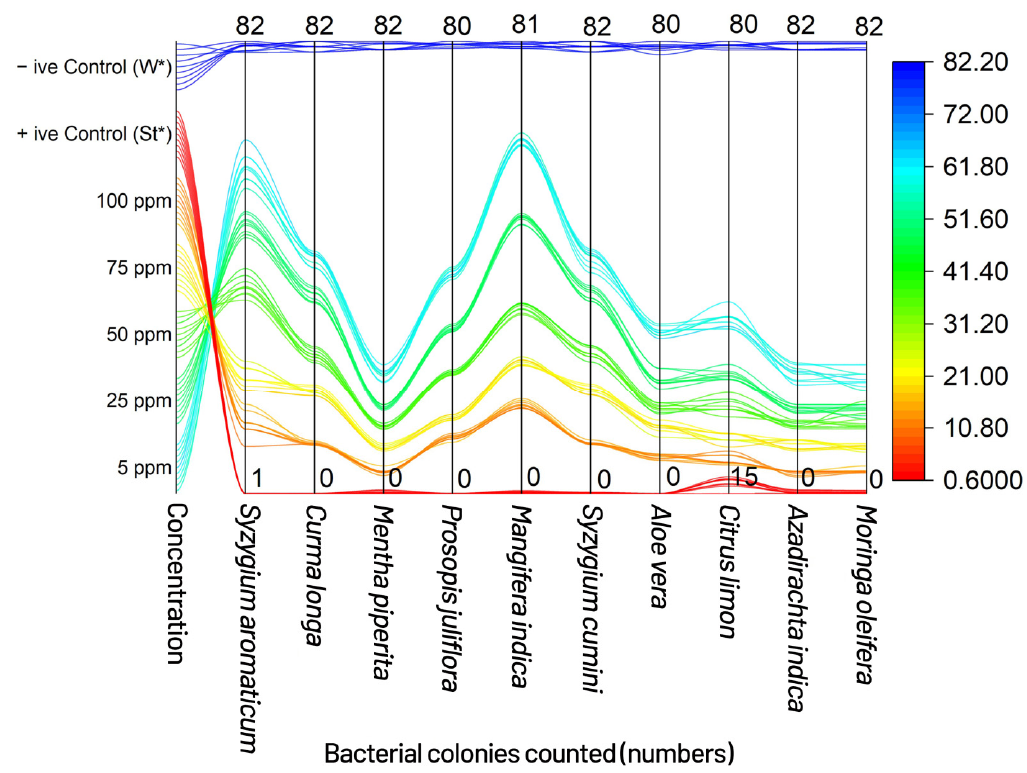
Figure 2. Sankey diagram showing the flow of various concentrations of treatments, communicating various levels of treatments concentrations towards counted bacterial colonies; +ive Control (St*) = Streptomycin, which was used as standard, and similarly, –ive Control (W*) = water, which was used to compare the results with aqueous extracts (botanicals) and streptomycin.